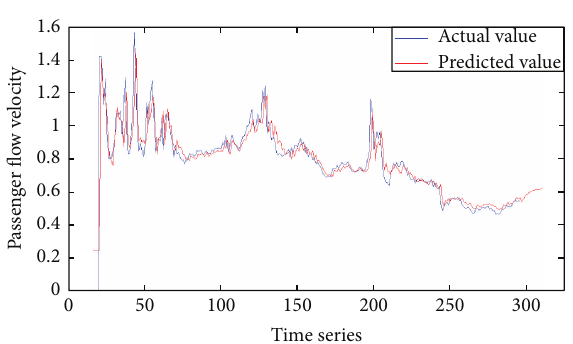
Figure 4: Comparion between actual value and forecasting value of passenger flow velocity based on RBF NN.